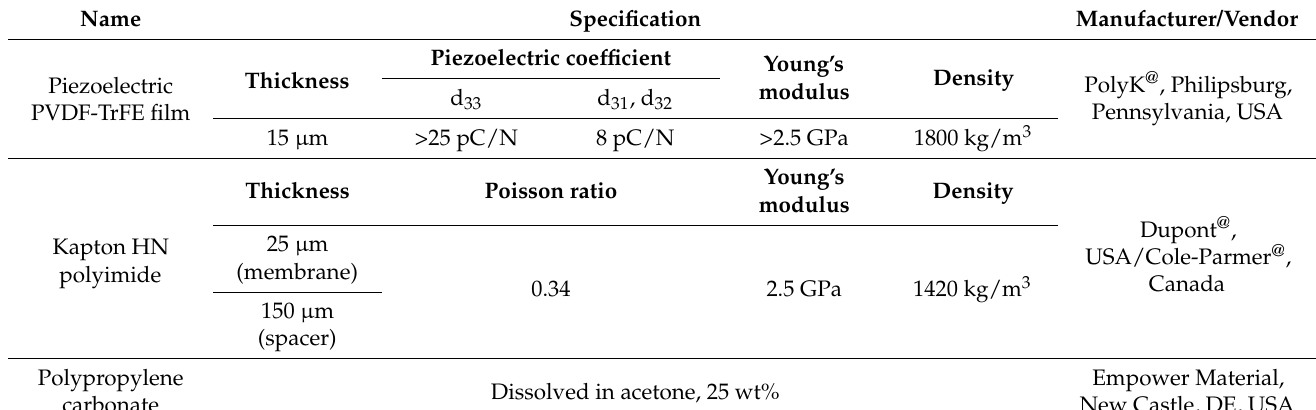
Table 2. Materials used to fabricate MEMS structures to test the quality of the new microfabrication flow.